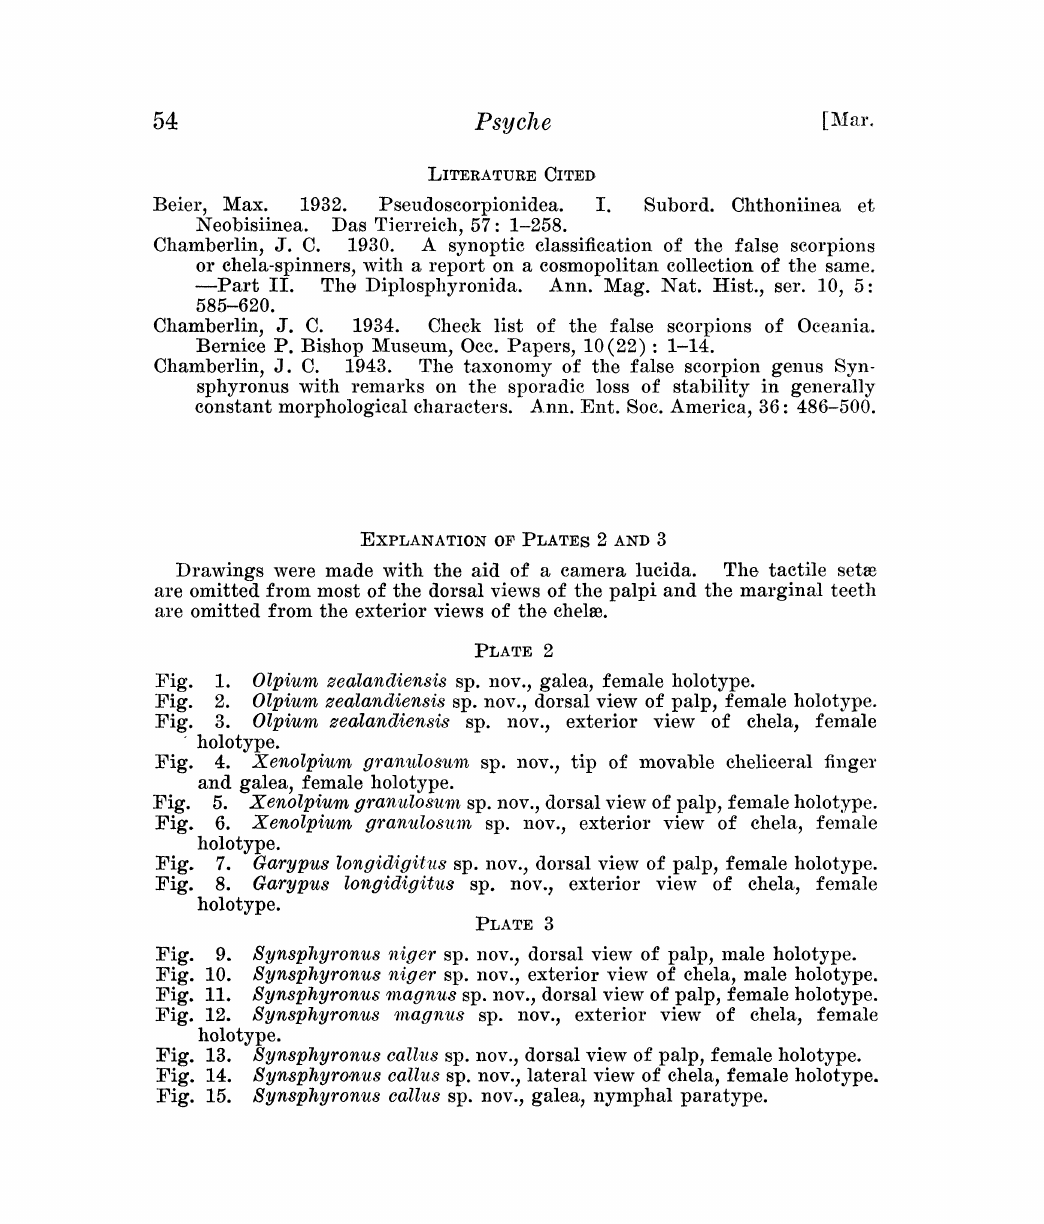
Fig. 1. Olpium zealandiensis sp. nov., galea, female holotype. Fig. 2. Olpium zealandiensis sp. nov., dorsal view of palp, female holotype. Fig. 3. Olpium zealandiensis sp. nov., exterior view of chela, female holotype. Fig. 4. Xenolpium granulosum sp. nov., tip of movable cheliceral fingm’ and galea, female holotype. Fig. 5. Xenolpium granulosum sp. nov., dorsal view of palp, female holotype. Fig. 6. Xenolpiu granulosu.m sp. nov., exterior view of chela, felnale holotype. Fig. 7. Garypus longidigits sp. nov., dorsal view of palp, female holotype. Fig. 8. Garypus longidigitus sp. nov, exterior view of chela, female holotype. Fig. 9. Synsphyronus niger sp. nov., dorsal view of palp, male holotype. Fig. 10. Synsphyronus niger sp. nov., exterior view of chela, male holotype. Fig. 11. Synsphyronus magnus sp. nov., dorsal view of palp, female holotype. Fig. 12. Synsphyronus magnus sp. nov., exterior view of chela, female holotype. Fig. 13. Synsphyronus callts sp. nov., dorsal view of palp, female holotype. Fig. 14. Synsphyro.nus callus sp. nov, lateral view of chela, female holotype. Fig. 15. Synsphyronus callus sp. nov., galea nymphal